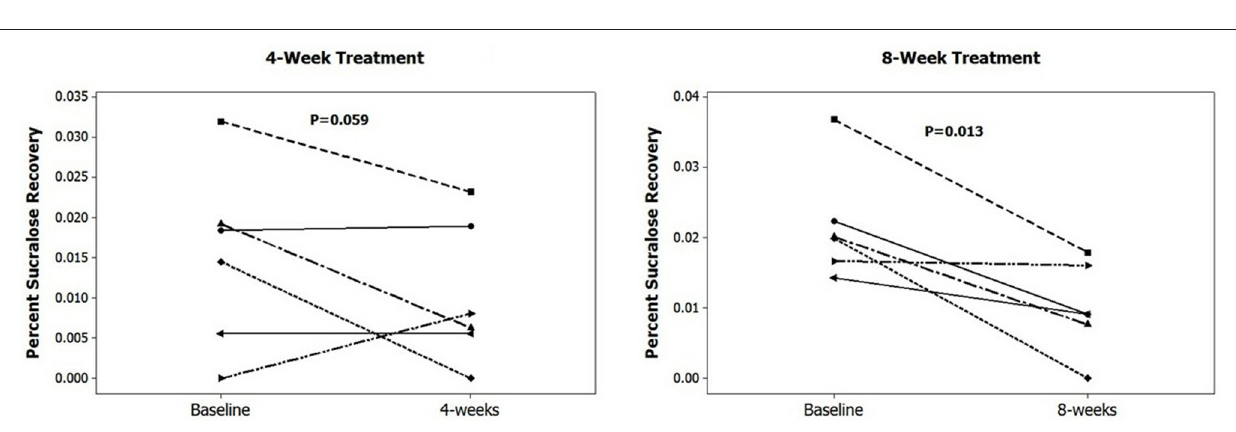
(47), and deconjugation by VSL#3 could constitute a protective mechanism as this is a bile acid species that is also known to disrupt epithelial barrier